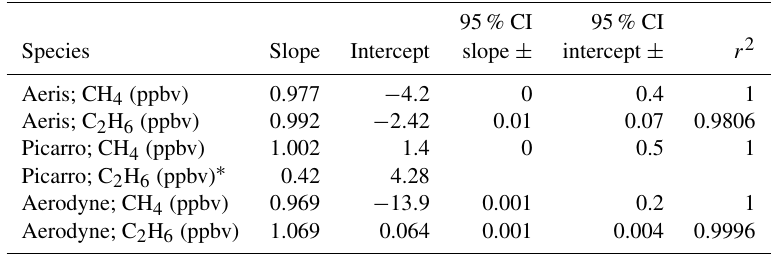
Table 2. Calibration span (slope) and zero (intercept) calculated for each instrument reporting at 1Hz when sampling the NOAA calibration standards. The 95% confidence intervals (CI) for the slope and intercept of an ordinary-least-squares (OLS) fit are also shown. 95% CI 95% CI